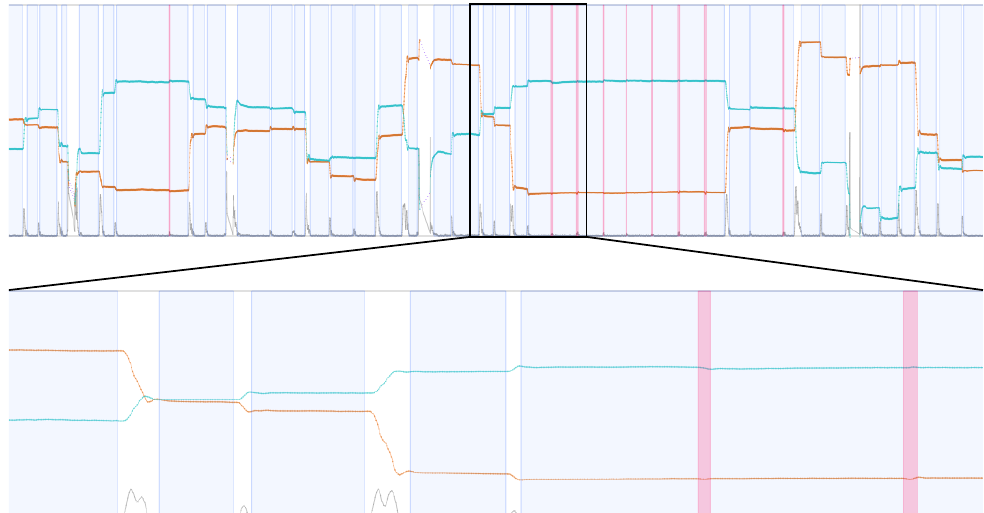
Figure 3 . Timeline view: timeline (top) and zoomed timeline (bottom) to explore more details. Timelines show the eye positions in x (orange) and y (turquoise) direction, the velocity (gray) determined by these positions, missing data ranges (purple) in x and y direction, fixation areas (blue), and microsaccade locations